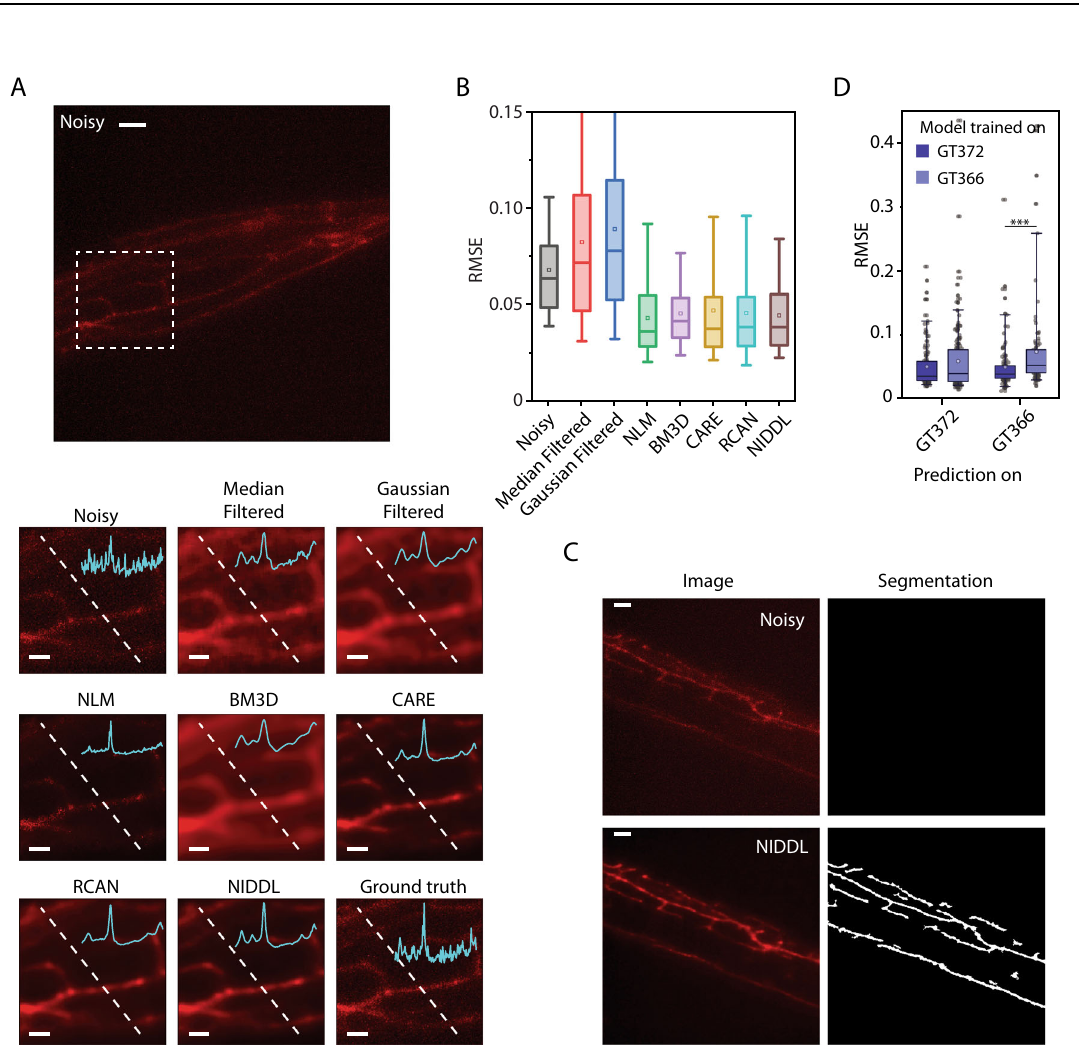
from the noisy video for worm 2 in the above image. (Middle right) mean of ROI averaged neuron activities extracted from noisy video. (Bottom left) single pixel neuron activities extracted from the denoised video. (Bottom right) ROI averaged neuron activities extracted from the denoised video. Arrows indicate examples of activity transients lost when averaging across an ROI in noisy video. In contrast, clear activity transients are present in both single pixel and ROI pixel traces extracted from NIDDL denoised video. D (Top left) input noisy (low laser power) max-projectionofanimagestackfromalargeFOVvideorecordingshowingventral cord motor neurons in a freely moving animal (scale bar − 10 μ m). (Bottom left) output image deep-denoised by NIDDL (scale bar − 10 μ m).(Top right) single pixel neuron activities extracted from the noisy video. (Bottom right) corresponding single-pixel neuron activities extracted from the deep-denoised video (arrows indicatingcoordinatedactivities).Alldatain A – D werecollectedonstrainOH16230 using a 20×, 0.75 NA objective (online methods).